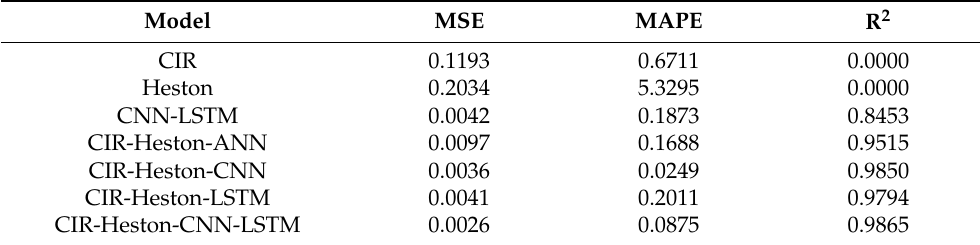
Figure 7. Comparison of real and predicted results of CSI 300ETF call options. Table 5. Comparison of the prediction accuracy between the different models.